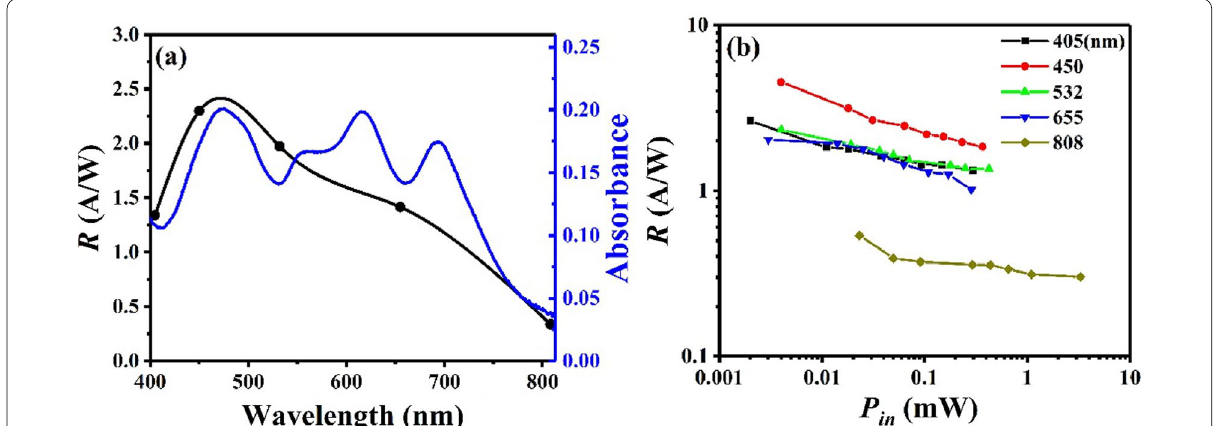
10 V and an incident optical power of ~ 0.1 mW −